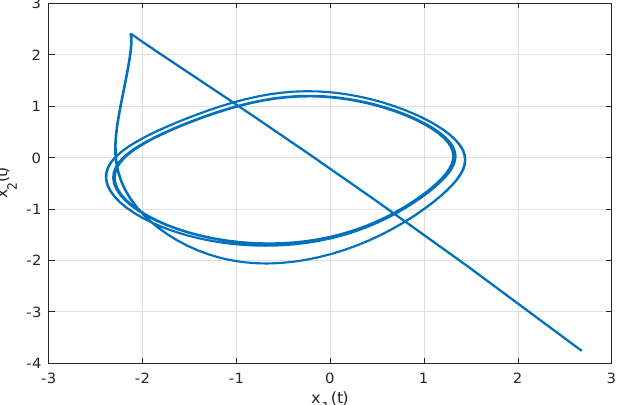
Figure 4. Phase plane of INNs (21) without any control